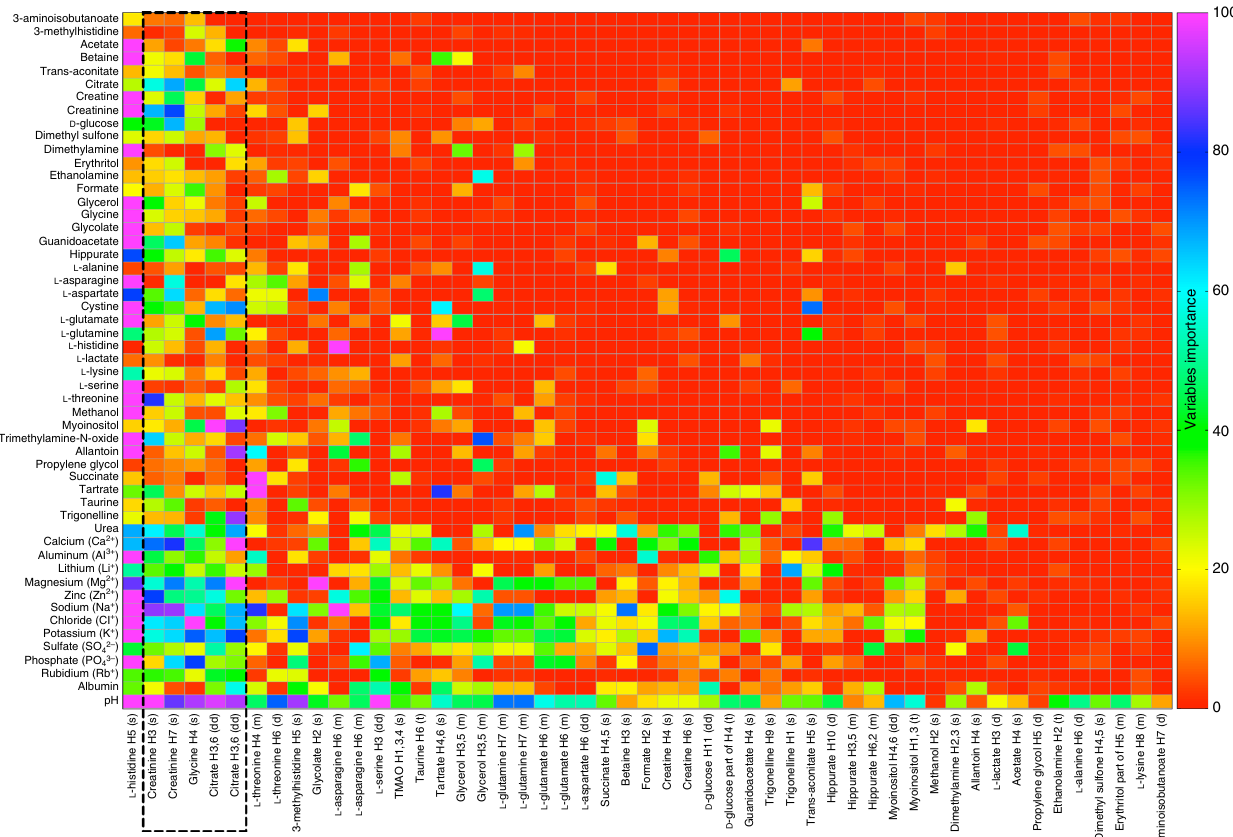
Fig. 3 Importance of metabolite concentrations in determining chemical shifts and vice versa. The importance of the concentrations of the metabolites listed on the y -axis in determining the chemical shifts of the metabolites listed on the x -axis is shown by the colored boxes (red lowest, violet highest). The same color codes describe the importance of the knowledge of the chemical shifts of the metabolites listed on the x -axis in predicting the concentrations of the metabolites listed on the y -axis. ANOVA decomposition (Methods) of the models predicting concentrations and pH yielded the most important variables for the construction of the models themselves, as well as their relative importance for the best fi tting accuracy. For instance, as depicted, chemical shifts values of 3-aminoisobutyrate H7 protons (last column) were needed for predicting the concentration of very few metabolites, and their signi fi cance was always very low ( < 2), except for predicting pH ( ≈ 9). Conversely, the chemical shift of the L -histidine H5 proton ( fi rst column) is needed for the prediction of almost all metabolite concentrations as well as of pH, and appears always as a very important (20 – 100) variable. The 10 most frequently employed 1 H NMR signals for model construction are from the L -histidine H5, creatinine H3 and H7, glycine, citrate H3,6, L -threonine H4 and H6, 3-methylhistidine H5, and glycolate H2 protons. The chemical shift ranges of these signals are large (Supplementary Table 1), and it appears that their variations are able to re fl ect the majority of the metabolite concentration (and pH) changes in the arti fi cial urine mixtures. These relationships could reasonably be translated into chemical interactions. For instance, the imidazole signals of L -histidine and, similarly, of 3-methylhistidine are very sensitive to any pH and/or ionic change, justifying why they are almost always important variables for predicting pH and the concentration of ions. Five spin systems (dashed box) from three metabolites — two doublets of doublets of citrate, two singlets of creatinine and one singlet of glycine — are easily identi fi able, very sensitive to the concentrations of the mixture components, and differently sensitive to the concentrations of different components, ensuring the broadest coverage of the concentration space. These spin systems are thus chosen as navigator signals, as they guide the search of the point in the concentration space that corresponds to that particular